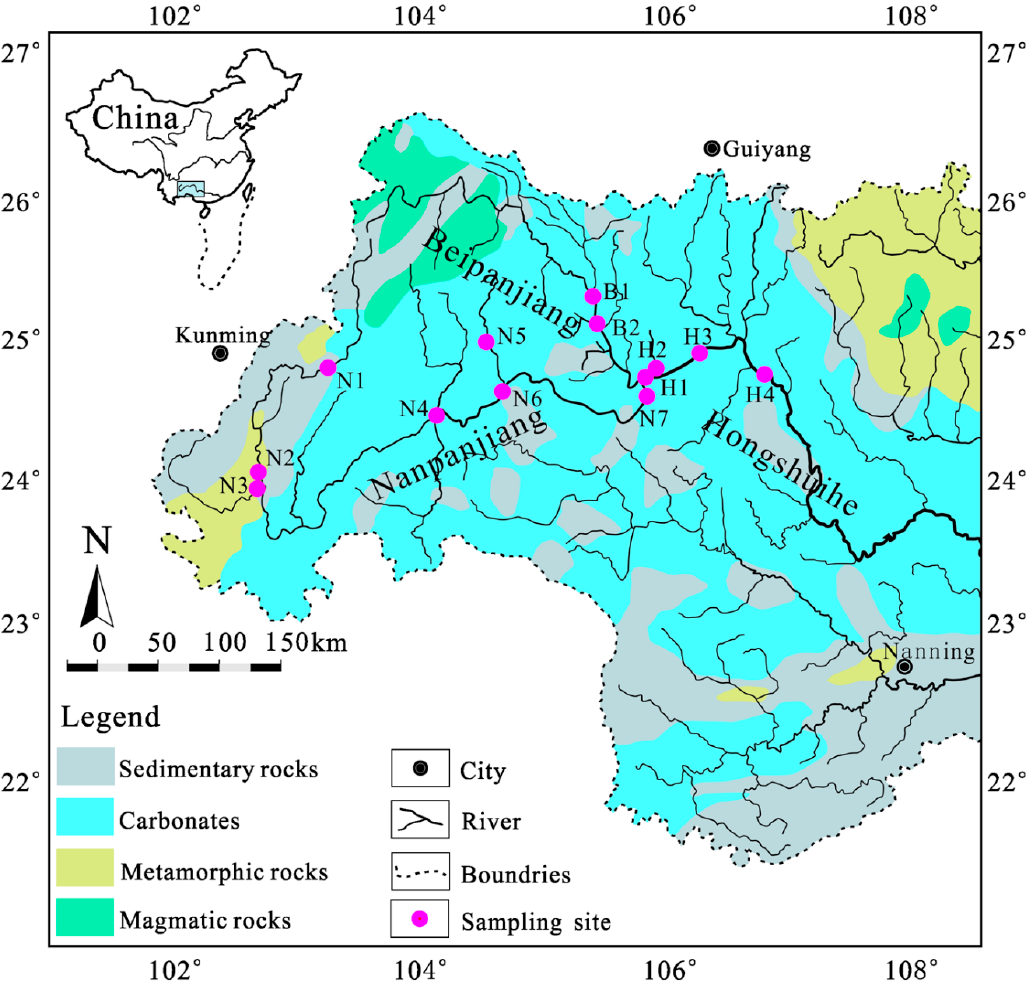
Figure 1. Map showing the lithology and sampling locations of the upper Xijiang River.